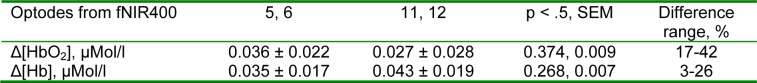
Commercial fNIRS device data comparison. Significance between pairs p< .5. N=11